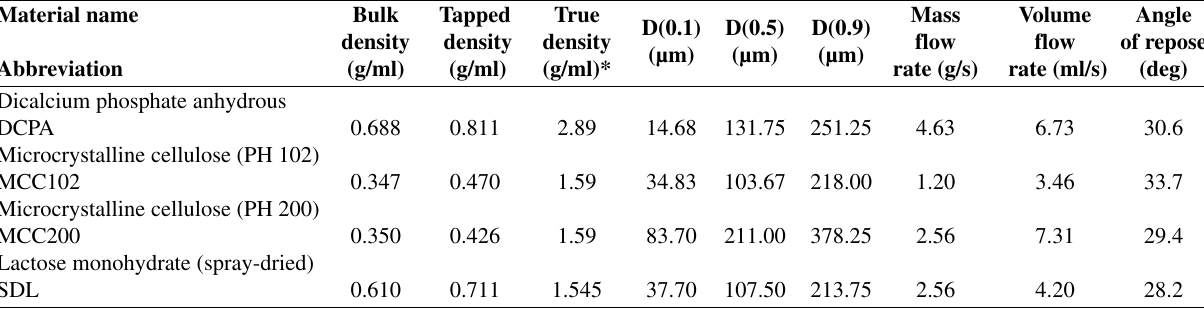
Table 1. Powder properties: bulk, tapped, 8 and true densities, 21 particle-size distribution D(0.1), D(0.5) D(0.9), 8 funnel measured mass and volume flow rates and angle of repose for tested materials, which include dicalcium phosphate anhydrous (DCPA), microcrystalline cellulose PH102 and PH200 (MCC102 and MCC200), and spray-dried lactose